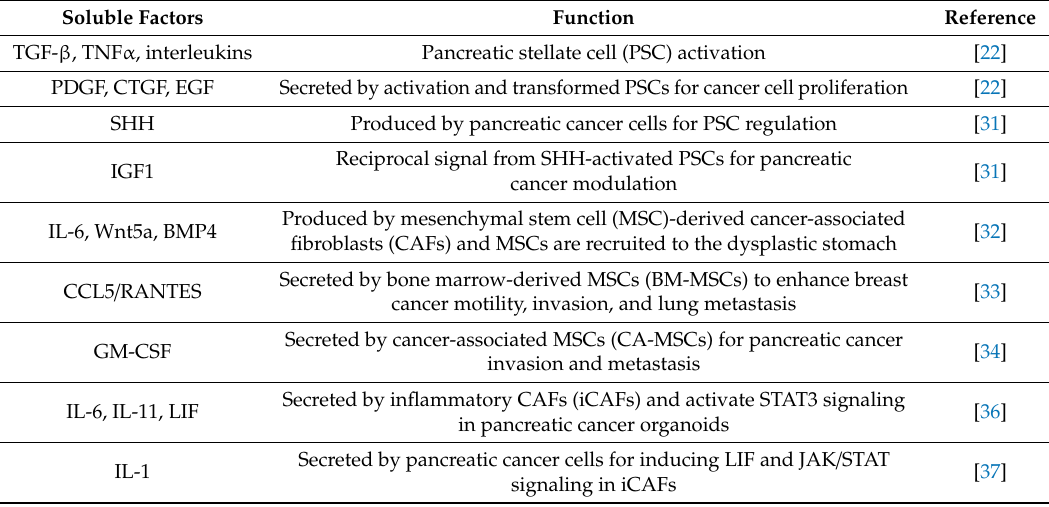
Table 2. Soluble factors and